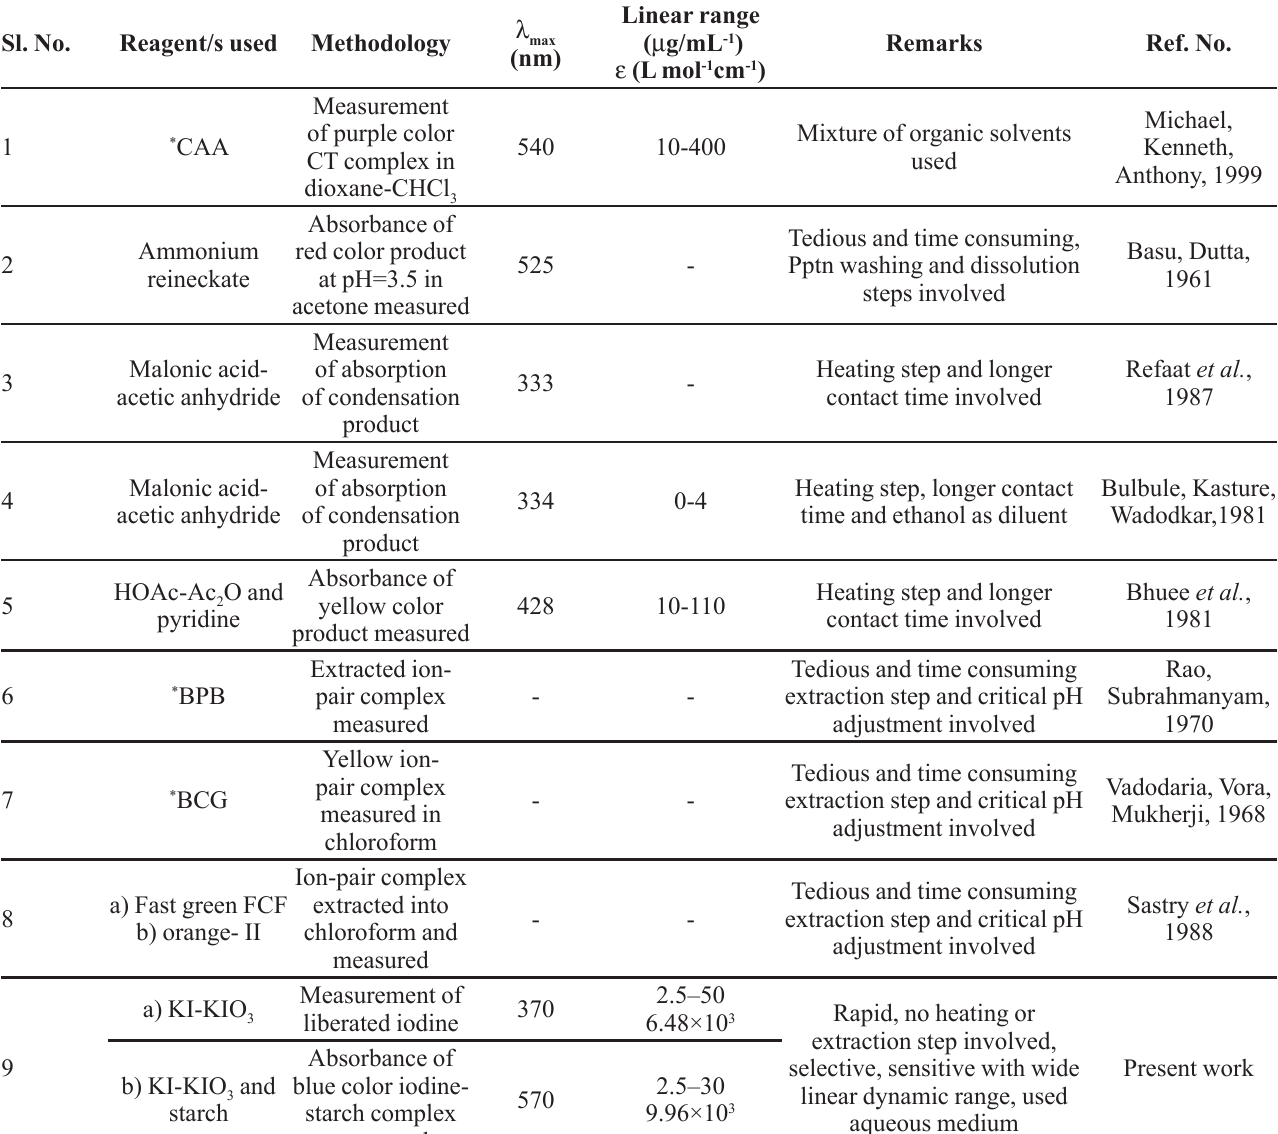
TABLE V - Comparison of performance characteristics of the present methods with the existing methods